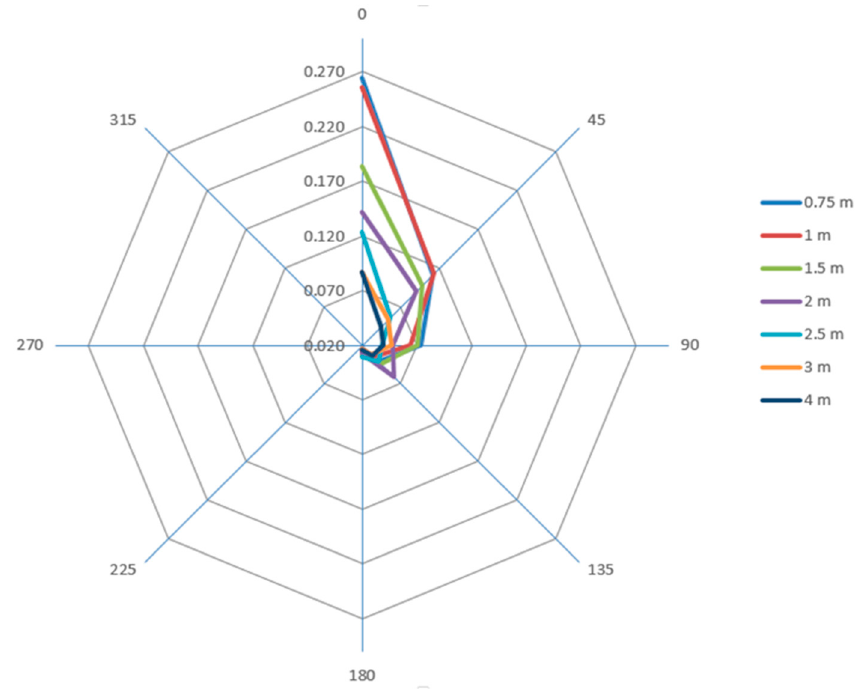
Figure 7. Spatial distribution of E-field measured near AS-RFID reader (V/m).